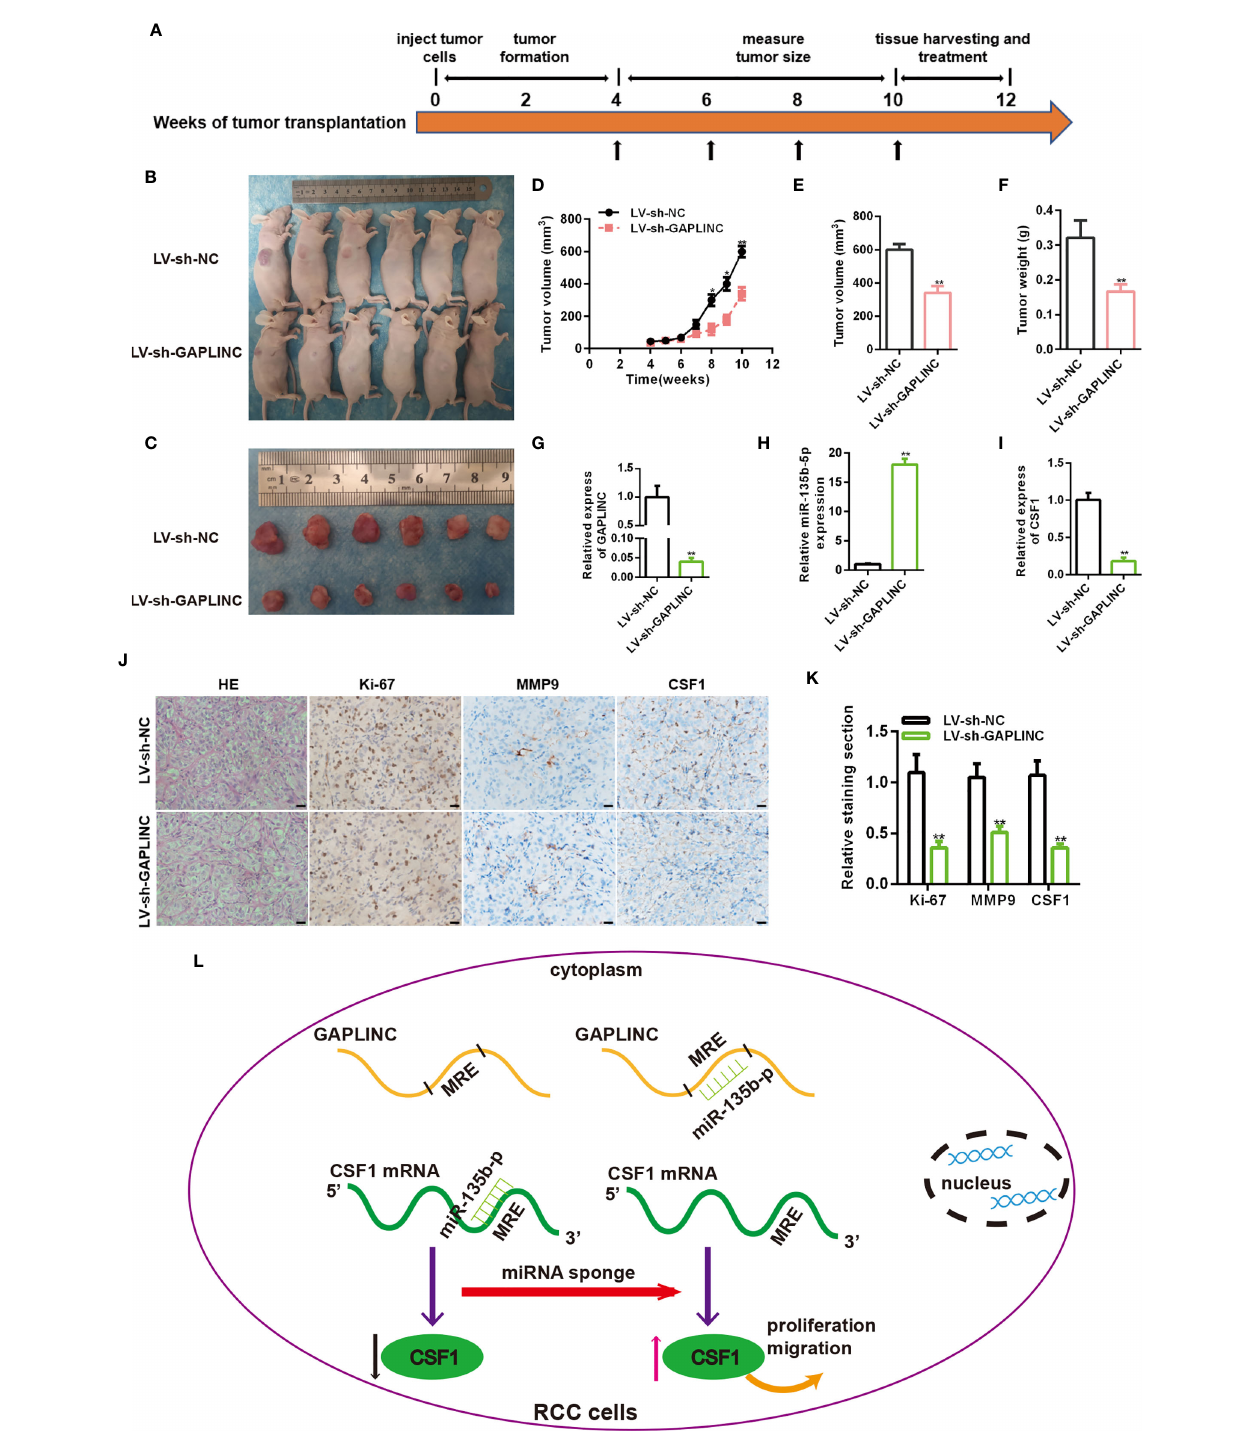
FIGURE 6 | Knockdown of GAPLINC inhibits the tumorigenicity of RCC in vivo . (A) Schematic representation of the nude mouse xenograft tumor experimental protocol. (B, C) Photographs of tumors obtained from the LV-sh-NC and LV-sh-GAPLINC groups of nude mice. The tumor volumes were measured once a week after tumor formation (D) , and the tumor nodules were removed 10weeks after transplantation, after which the fi nal volumes (E) and weights (F) were measured. Xenograft tissues were subjected to RT-qPCR to assess GAPLINC (G) , miR-135b-5p (H) and CSF1 (I) expression. (J, K) Representative images showing H&E, Ki- 67, MMP-9 and CSF1 staining of xenograft tumor tissues; the histogram shows the statistical analysis of their expression levels. Scale bars, 20 m m. (L) Schematic representation of the mechanism of GAPLINC in RCC cells. *p < 0.05; **p <